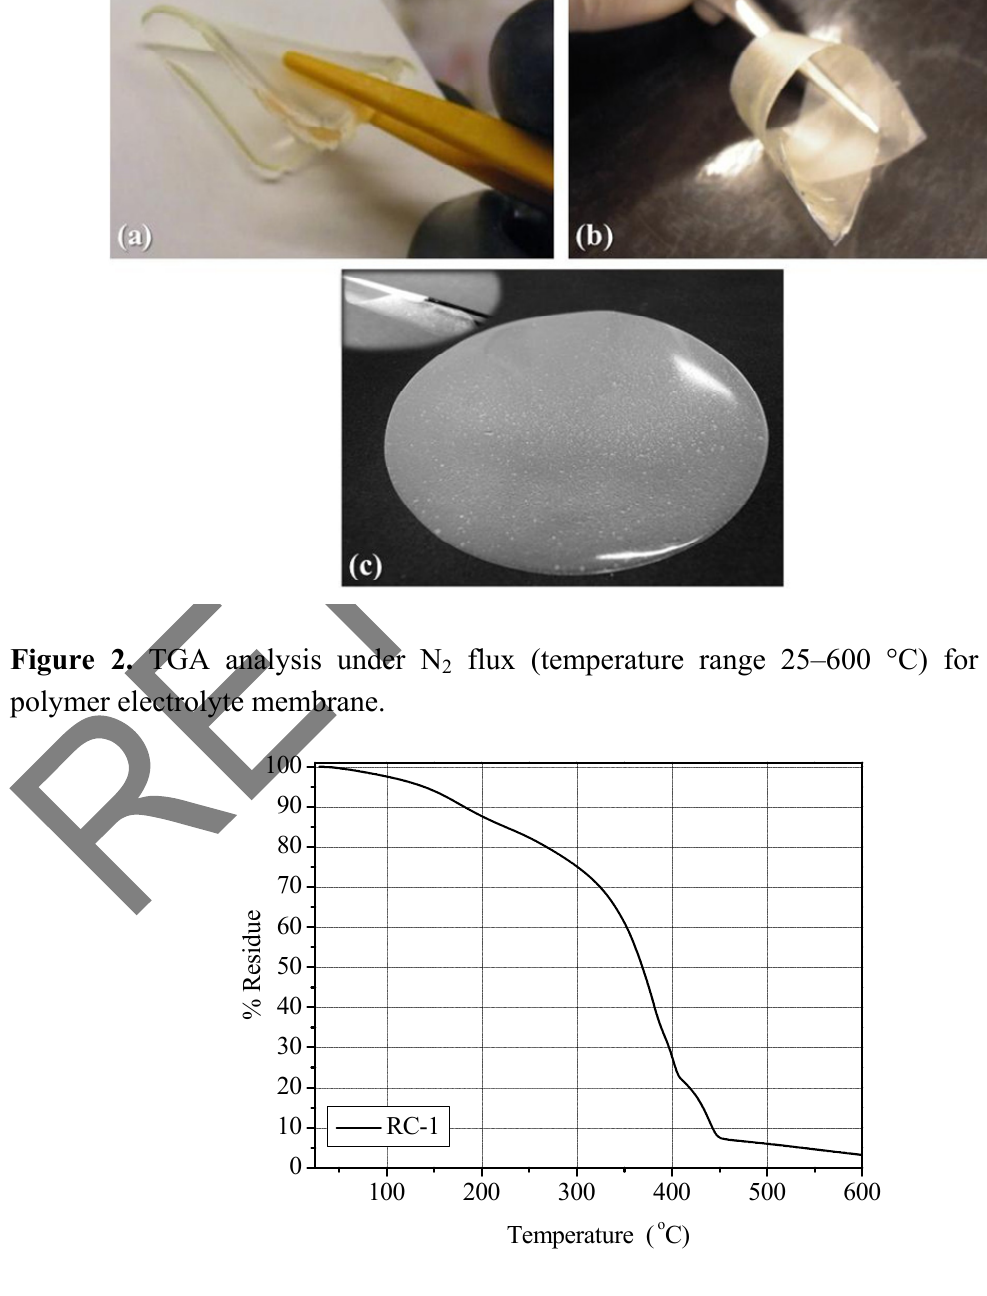
Figure 1. Appearance of the different quasi-solid polymer electrolyte membranes